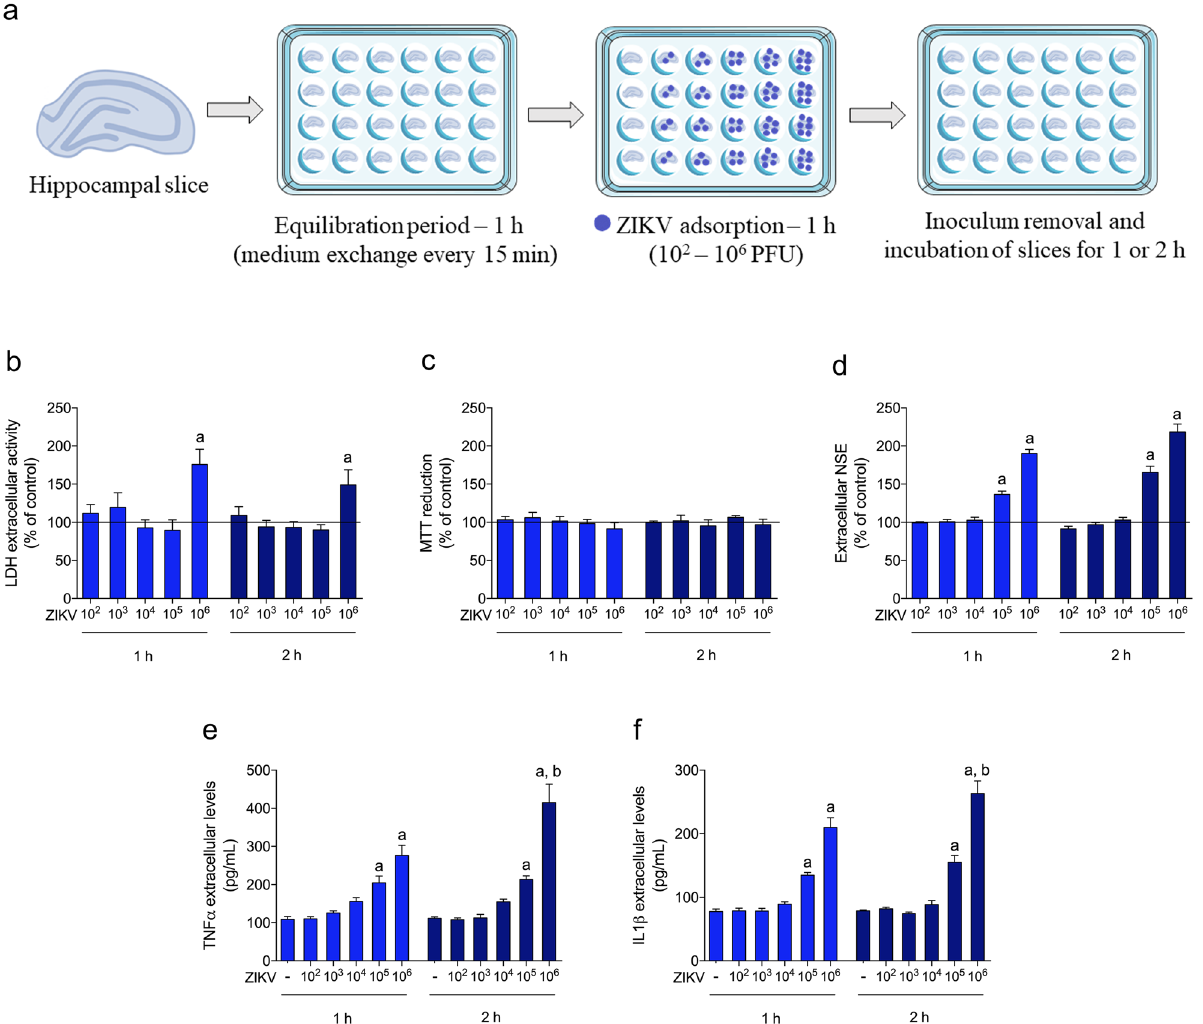
Figure 1. Effects of ZIKV on the hippocampus of adult rats. ( a ) Experimental design of ZIKV infection. Hippocampal slices (0.3 mm thickness) were obtained from adult rats and were maintained for an equilibration period of up to 1 h (cellular recovery), following ZIKV adsorption (10 2 –10 6 PFU) or non-infection control for 1 h. The inoculum was then washed out, and the slices were maintained for an additional 1 or 2 h; ( b ) extracellular LDH activity; ( c ) MTT reduction; ( d ) extracellular NSE activity. The line indicates the non-infection control value, assumed as 100%. Data represent means ± SEM of at least four experimental determinations performed in quadruplicate, analyzed by one-way ANOVA followed by Tukey’s test. Values of P < 0.05 were considered significant ( a indicates difference from control condition; b indicates difference between 1 and 2 h incubations after ZIKV inoculation). The release of TNFα ( e ) and IL1β ( f ) was evaluated using the extracellular medium of hippocampal slices after incubation with ZIKV (10 2 –10 6 PFU) or non- infection control (first column in the graphs). Data represent means ± SEM of at least four experimental determinations performed in quadruplicate, analyzed by one-way ANOVA followed by Tukey’s test. Values of P < 0.05 were considered significant ( a indicates difference from control condition; b indicates difference between 1 and 2 h incubations after ZIKV